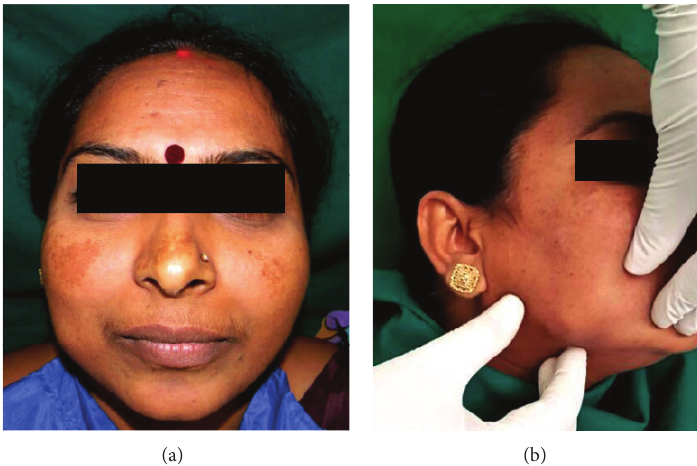
Figure 1: Extraoral frontal and right lateral view depicting the diffuse swelling on the right side of the face.